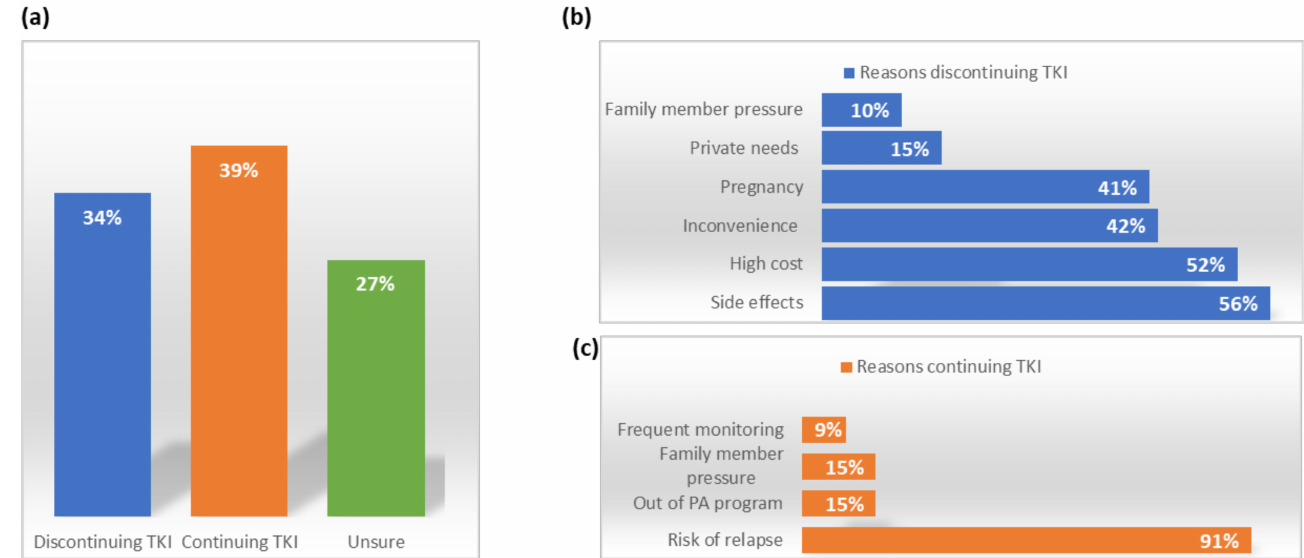
Figure 1. Percentage of patients willing to attempt TFR and the reasons given: ( a ) Percentage of patients willing to attempt TFR; ( b ) The reasons for discontinuing—the main reason that patents cited for wanting to for stopping TKI is the side effects; and ( c ) The reasons for continuing TKI treatment—the main reason patients wanted to continue treatment was fear of relapse. Adapted from